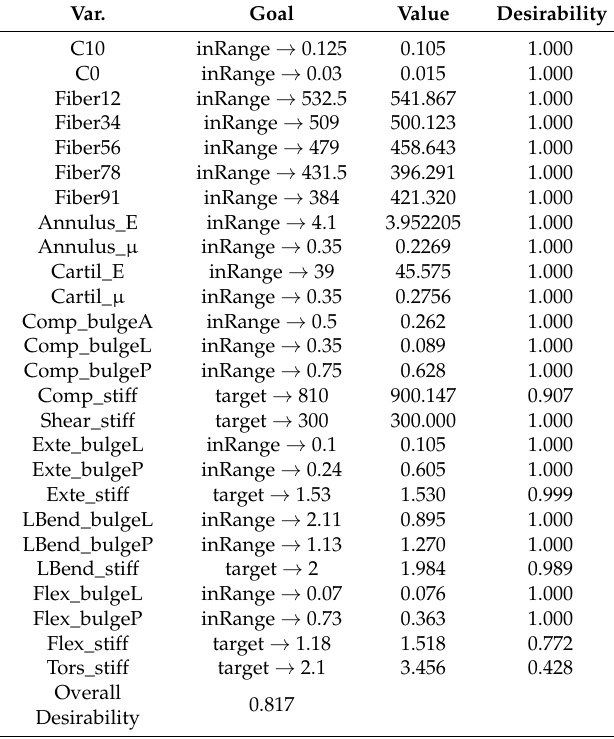
Table 29. The second criterion considered: setting the target of the FE model parameters based only on stiffness.